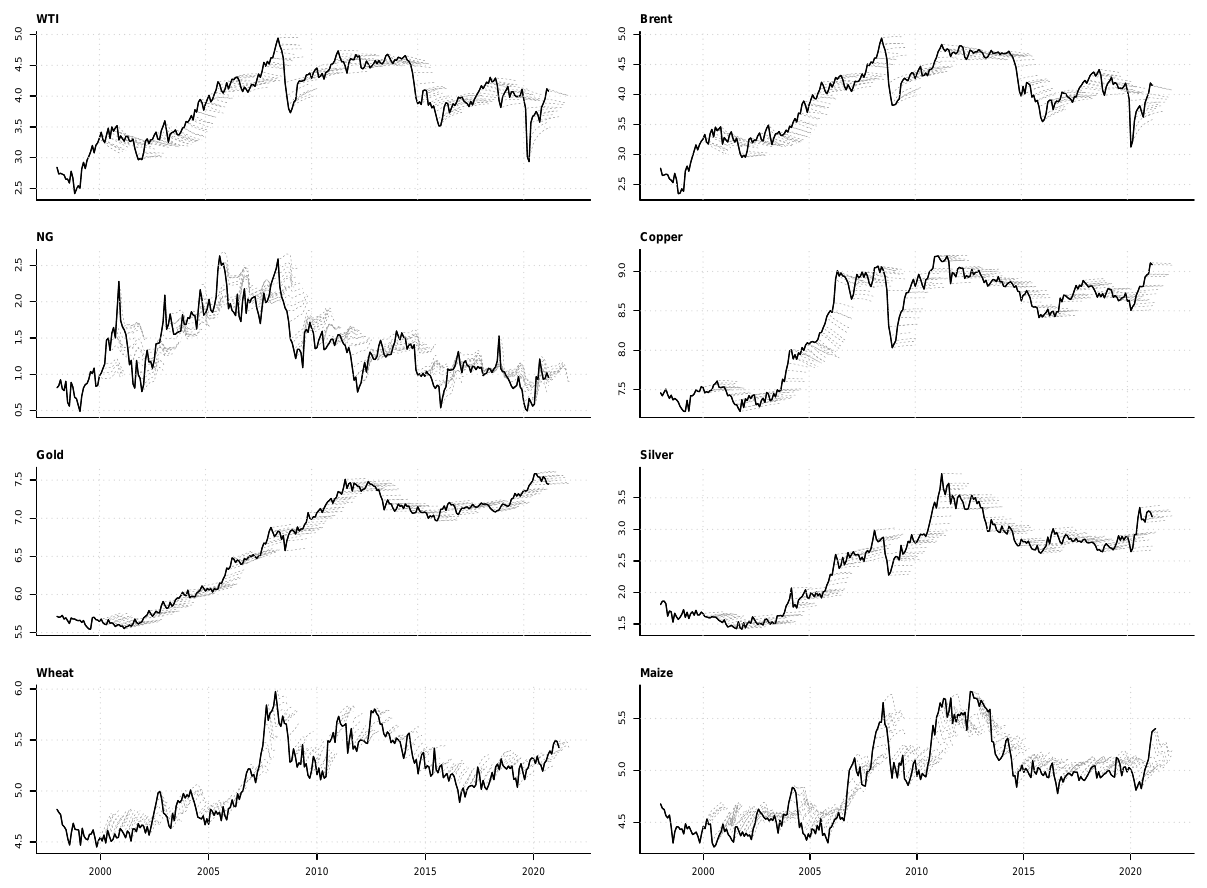
Figure 1. Sequential forecasts for nominal commodity prices. Notes: The figure presents recursive futures-based forecasts for the log of nominal commodity prices. Forecasts with 1 to 12 month horizons are evaluated for January 2000 to March